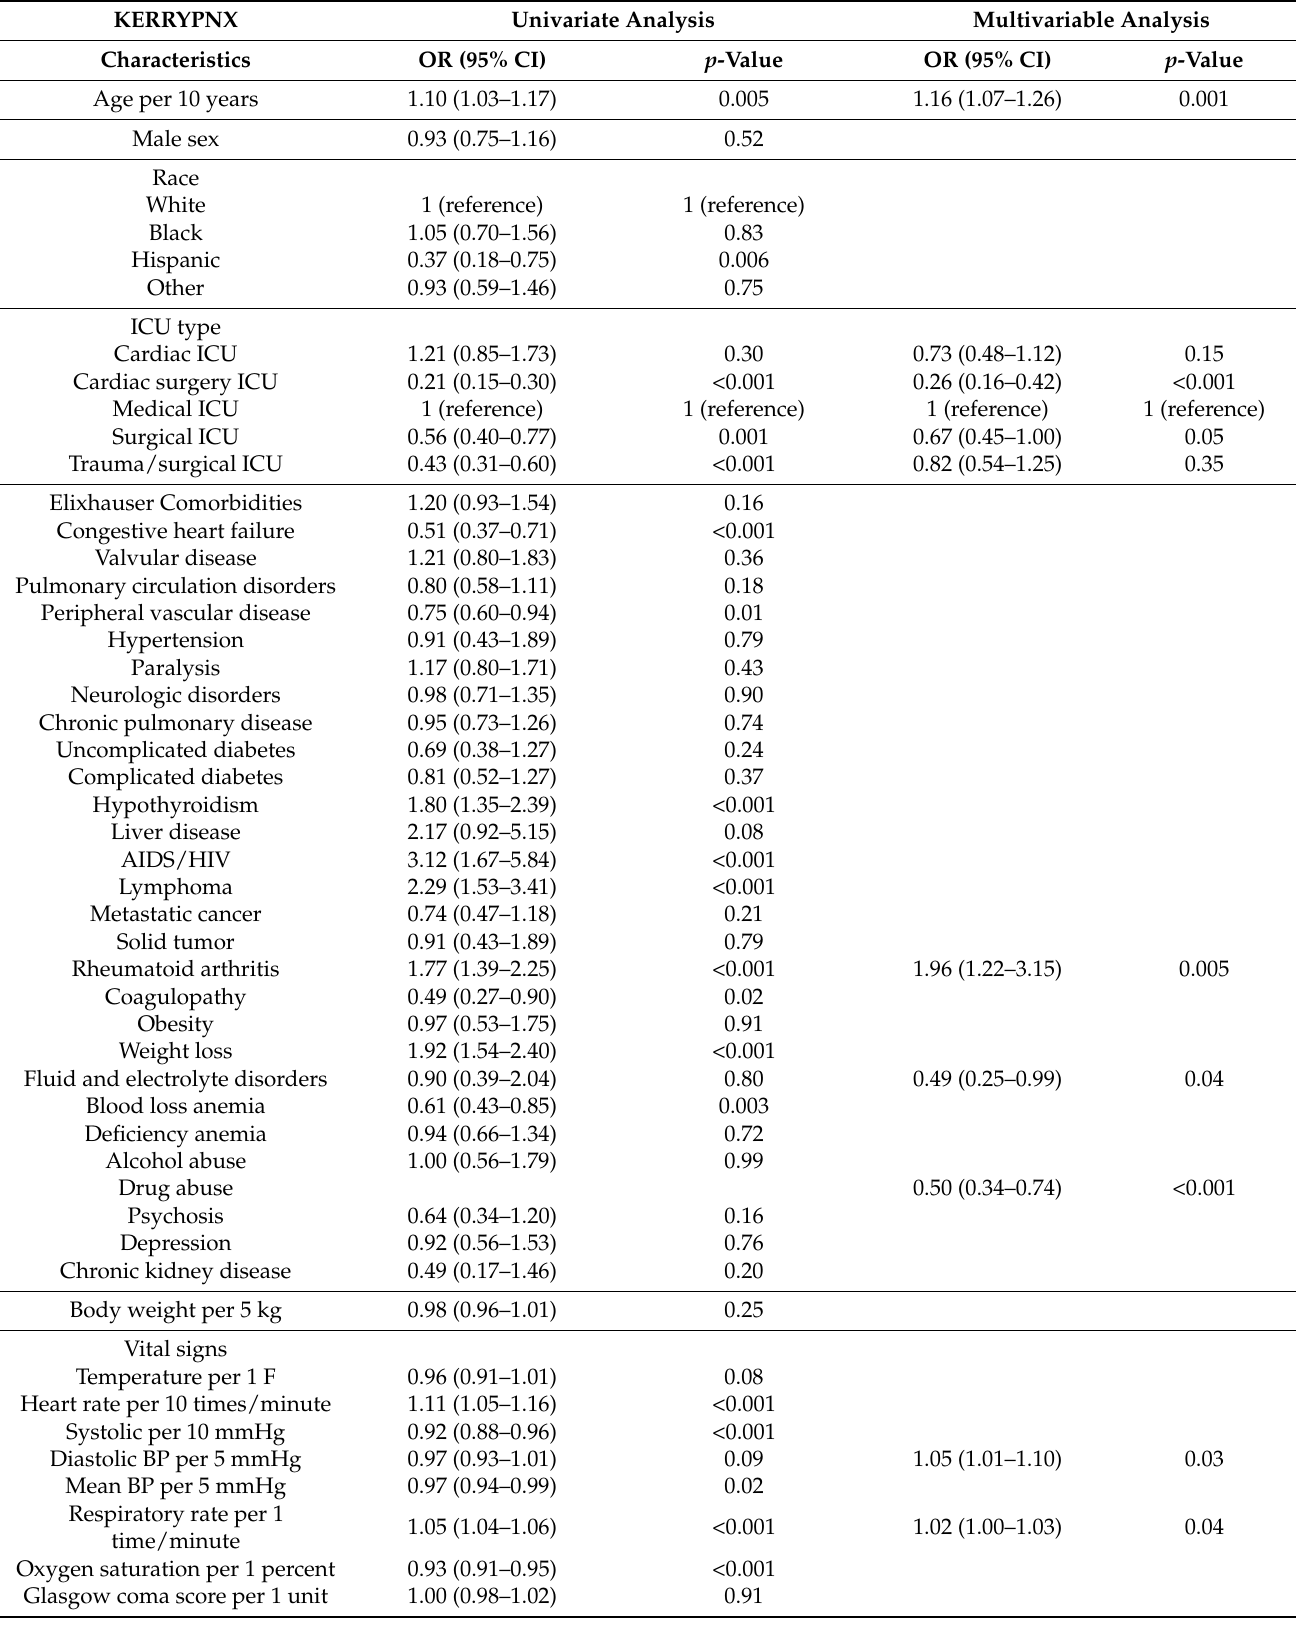
Table 3. Development of multivariable logistic regression model to predict mortality using stepwise variable selection in the training